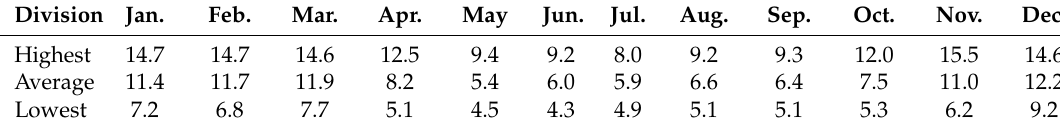
Table 3. First heated supply pressure (unit: kg/cm 2 g).